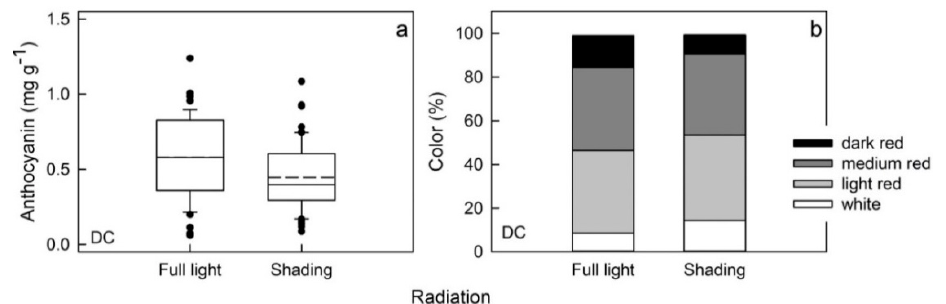
Figure 6. Effects of shading on the anthocyanin content ( a ) and the color distribution ( b ) of red flesh apples of a dark-colored (DC). Fruit exposed to full sunlight served as control. Shade reduced the incident photosynthetically active radiation by 94%.